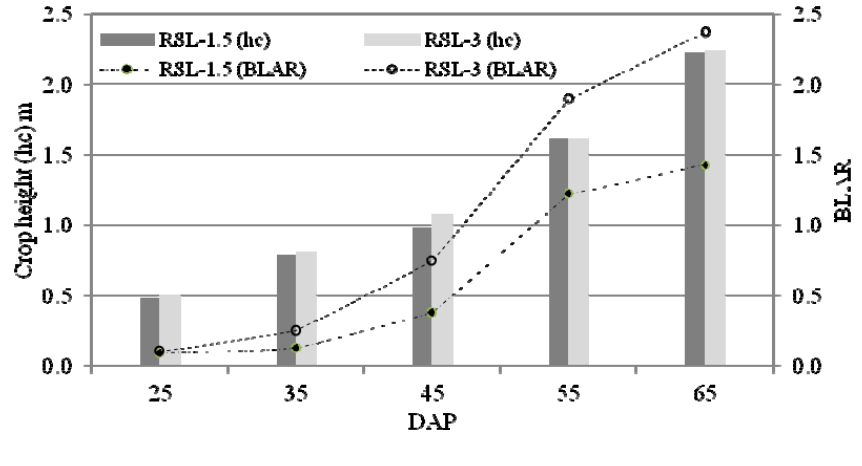
Figure 2. The changes in crop height ( hc ) and basin leaf area ratio (BLAR) during vegetative and reproductive stages at 10-day intervals from mid-January to March,